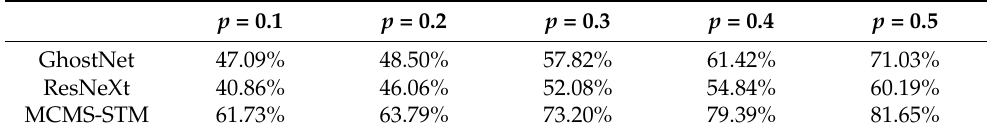
Table 8. The accuracies of the MCMS-STM and deep learning methods for dataset 1 under different numbers of training samples.